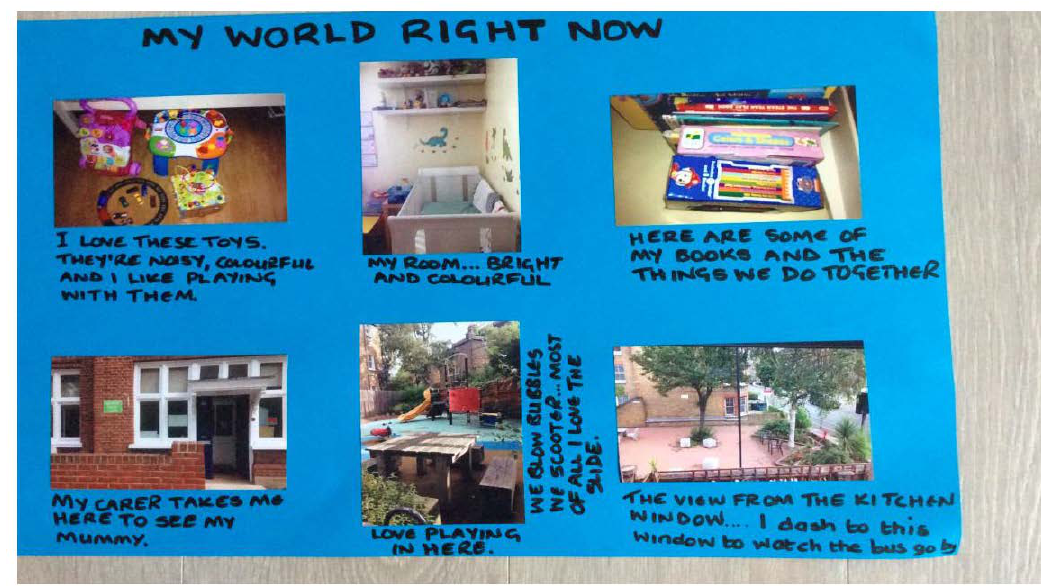
Figure 2. My world right now (Meetoo et al., 2020).